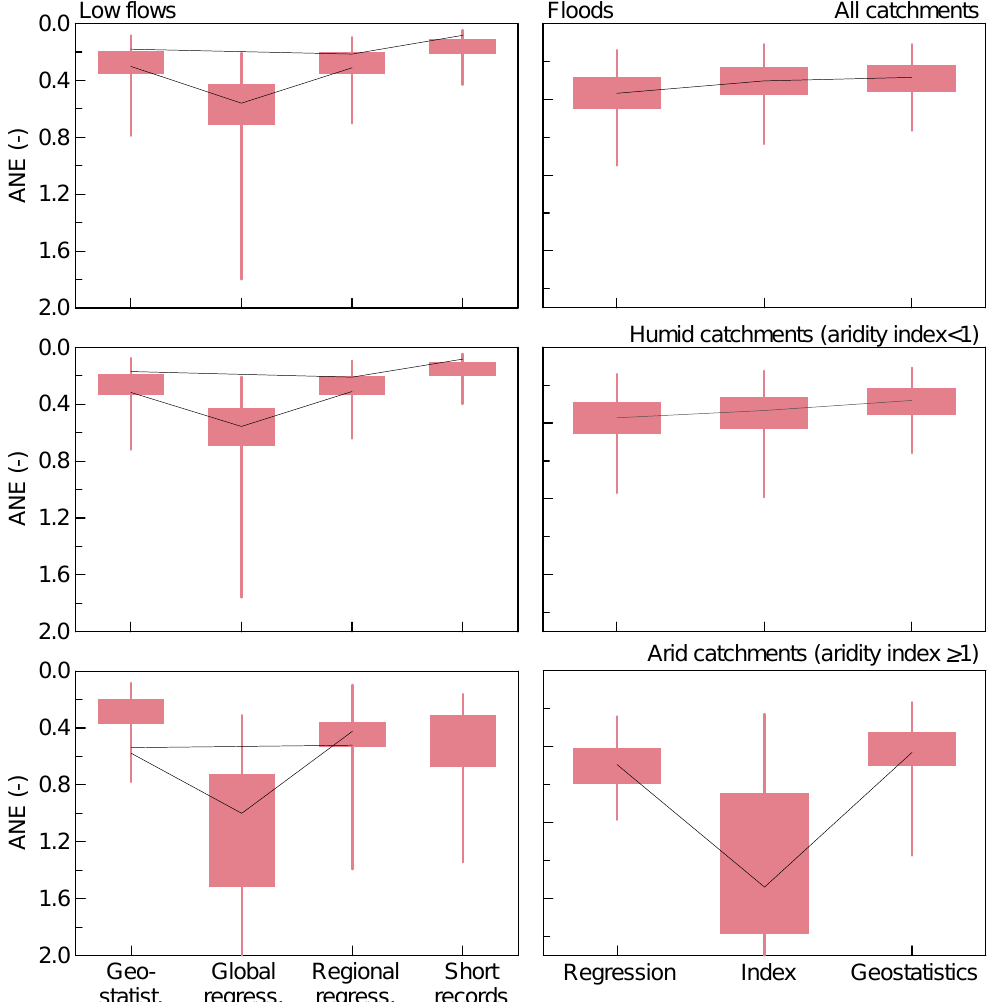
Fig. 6. Absolute normalised error of predicting q 95 low flows (m 3 s − 1 km − 2 ) , left panels, and q 100 floods (m 3 s − 1 km − 2 ) , right panels, in ungauged basins for different regionalisation methods, stratified by aridity (Level 2 assessment). Top: all catchments. Centre: humid catchments (aridity index < 1). Bottom: arid catchments (aridity index ≥ 1). Lines connect median efficiencies for the same study. Boxes are 40–60% quantiles, whiskers are 20–80%